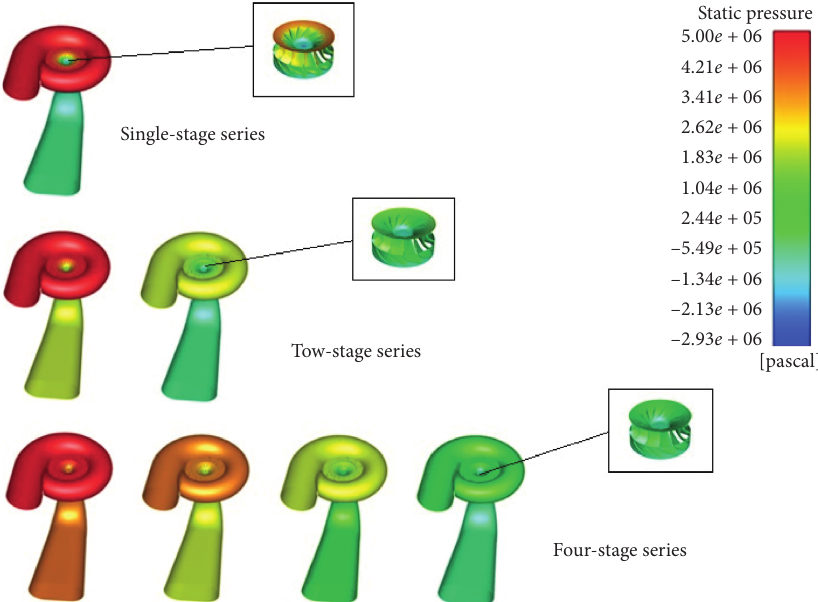
Figure 12: Pressure distribution of different series modes of small-size hydraulic